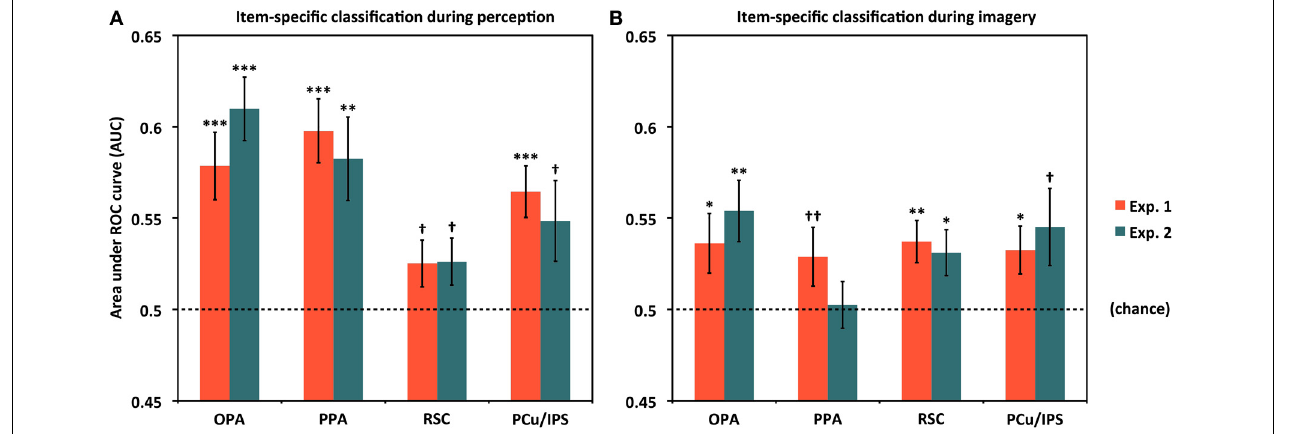
FIGURE 3 | Classifying individual scenes during perception and imagery by ROI. (A) Classification accuracy for distinguishing between different scene items during perception for Experiments 1 and 2. In all cases, classification was above chance (AUC = 0.5) either significantly or at a trend level. (B) Classification accuracy for distinguishing between different scene items